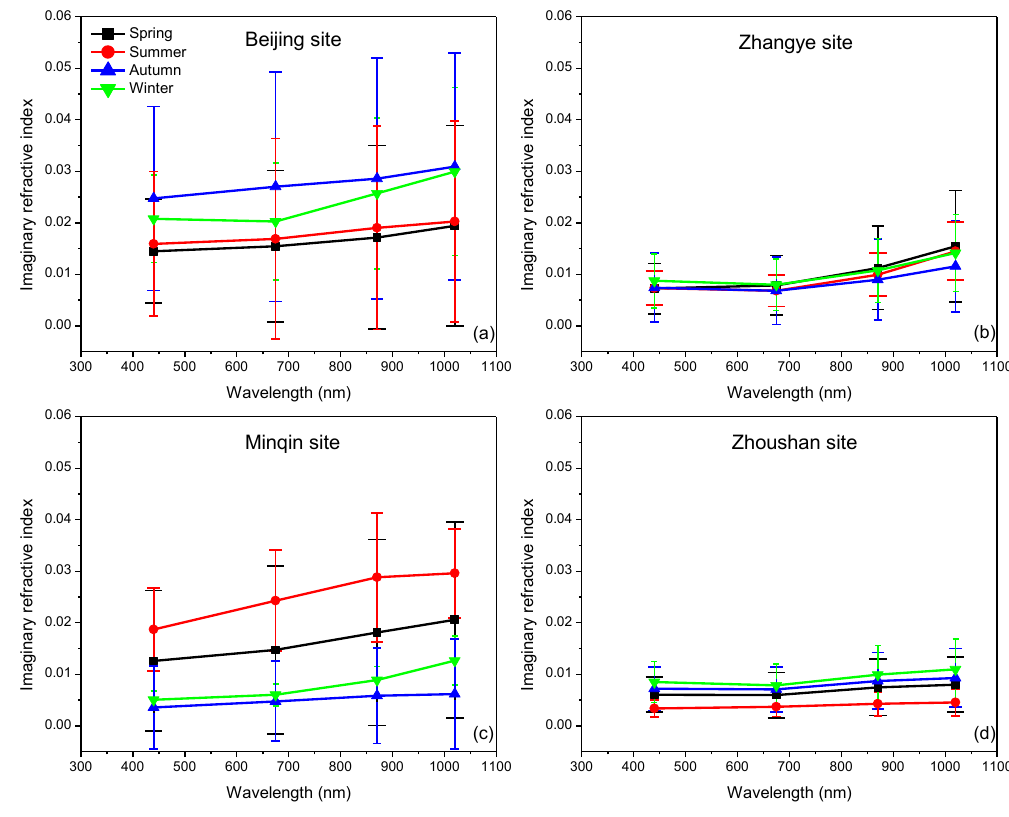
Figure 6. Seasonal average of imaginary refractive indices of the four sites, ( a ) Beijing site; ( b ) Zhangye site; ( c ) Minqin site; ( d ) Zhoushan site. Error bar indicates the standard deviation of the